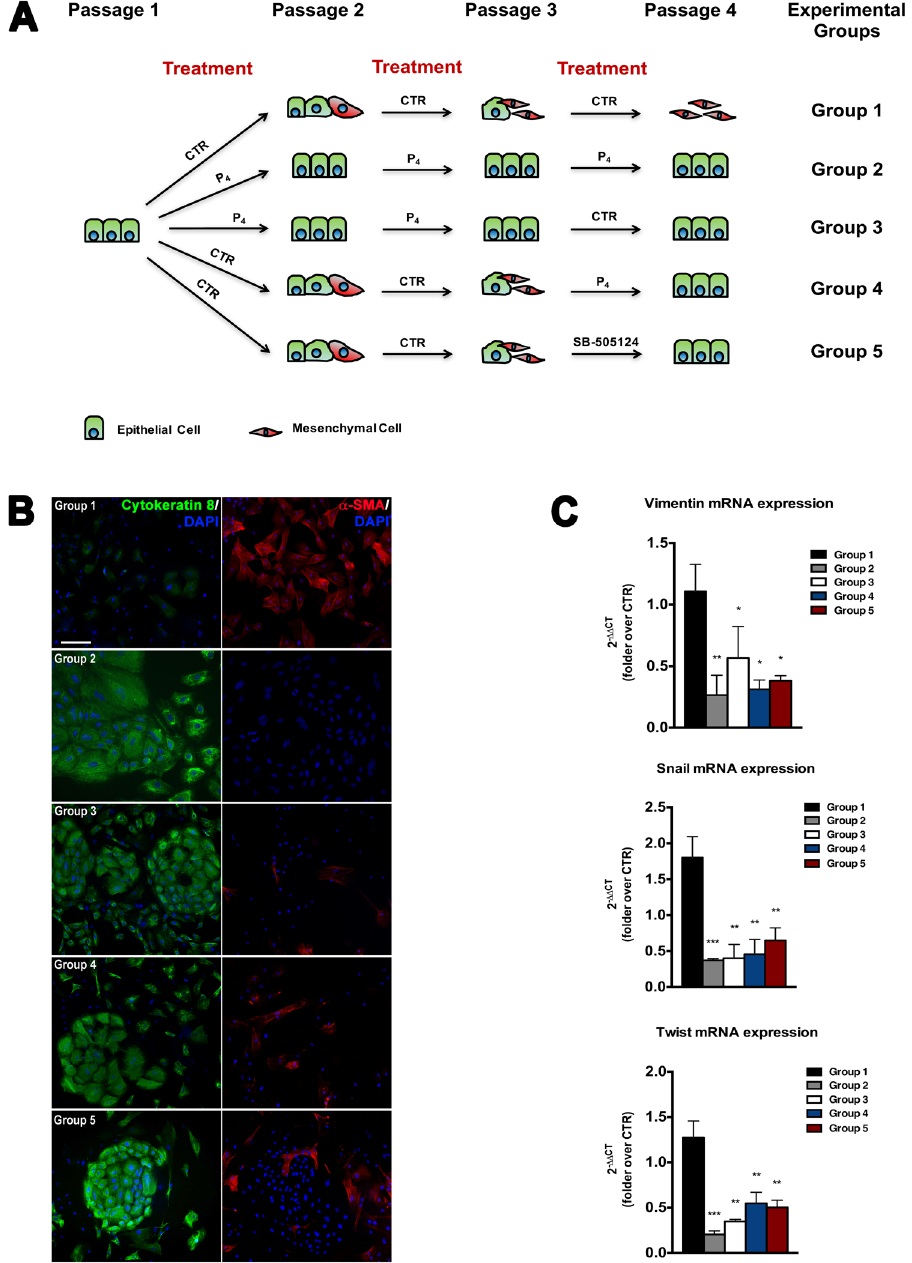
Figure 4. Effects of P 4 withdrawal and P 4 late exposure on oAEC phenotype and EMT-related gene expression. ( A ) Schematic representation of experimental design. Group 1 (CTR cells); Group 2 (P 4 -treated oAEC); Group 3 (P 4 withdrawal from passage 3); Group 4 (CTR cells exposed to P 4 from passage 3); Group 5 (CTR cells exposed to SB-505124 from passage 3). ( B ) Immunocytochemistry of Cytokeratin-8 and α -SMA in the different experimental groups. Scale bar: 100 µ m. ( C ) Real-Time qPCR analysis of EMT-related genes Vimentin , Snail and Twist in the same experimental groups. The ΔΔ Ct values of passages 4 are calculated by normalizing the relative Δ Ct values against the Δ Ct values obtained from CTR and P 4 -treated oAEC at passage 3, respectively. Data are the mean ± SEM, from n = 3 independent experiments performed in triplicate. * p < 0.05, ** p < 0.01 and *** p < 0.001. Abbreviation: CTR, control cell; P 4 ,